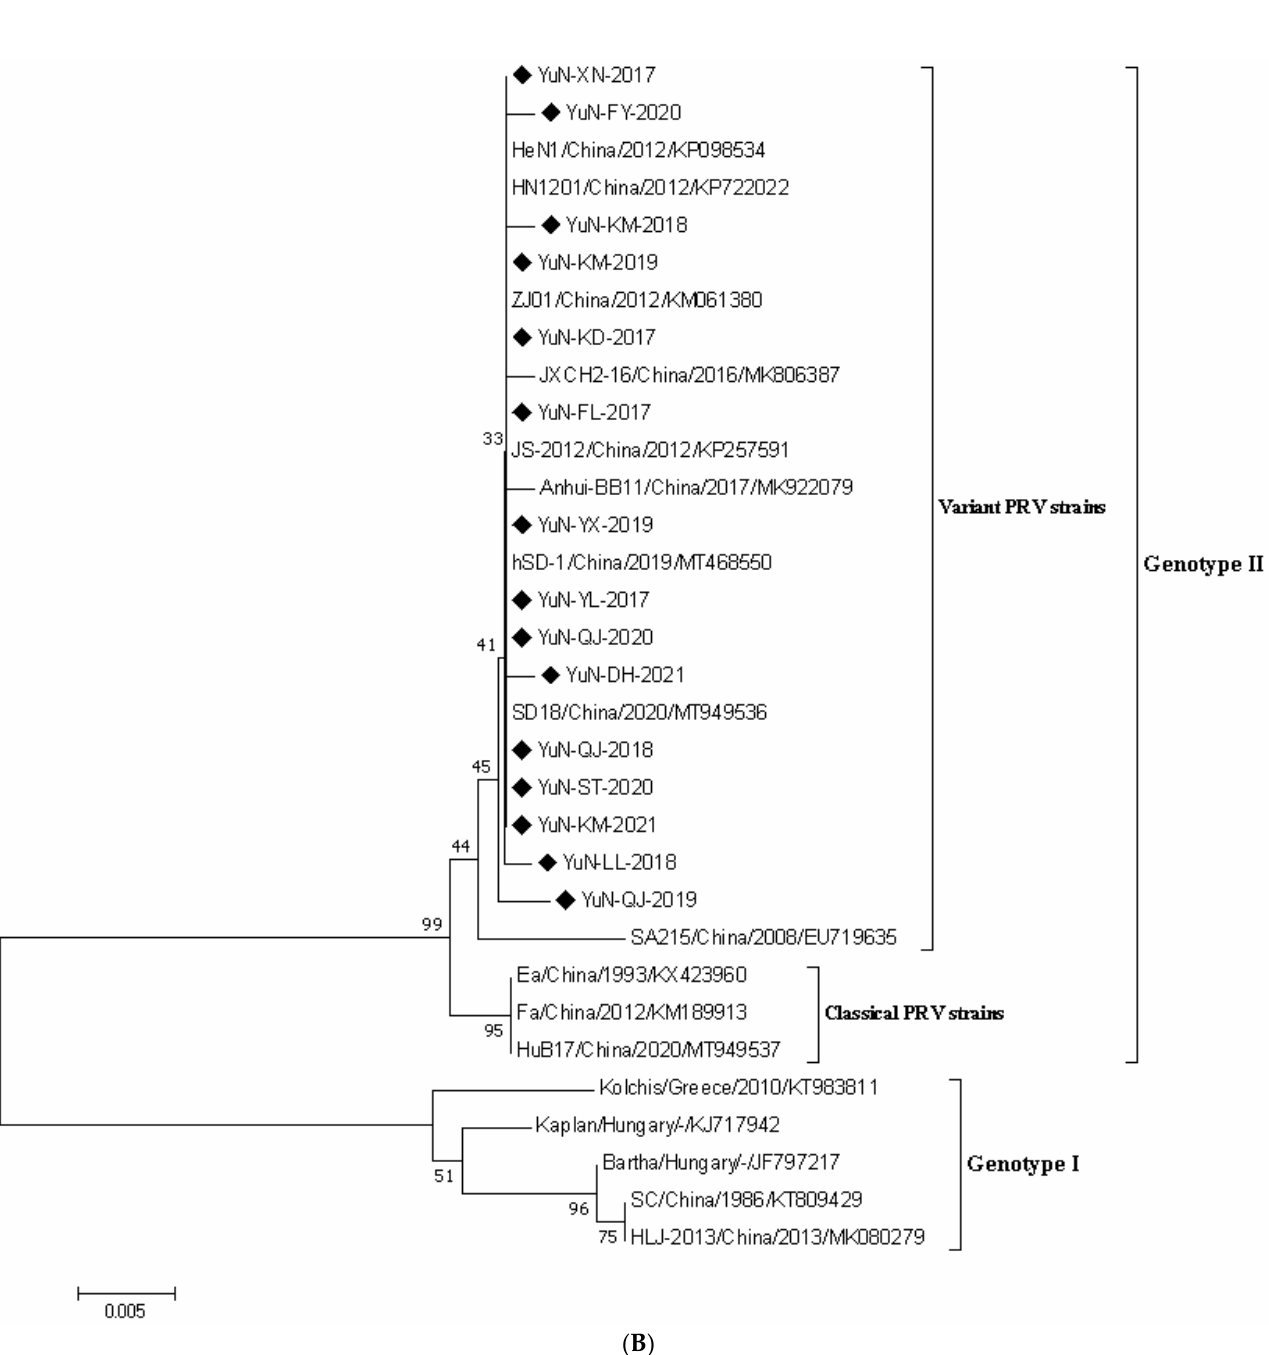
Figure 1. Phylogenetic analysis based on the nucleotide sequences of gE ( A ) and gC ( B ) genes of the 15 novel PRV isolates obtained in this study and other reference strains. A phylogenetic tree was generated using the neighbor-joining method with 1000 bootstrap replicates in MEGA X software. The black triangle represents the 15 PRV isolates.